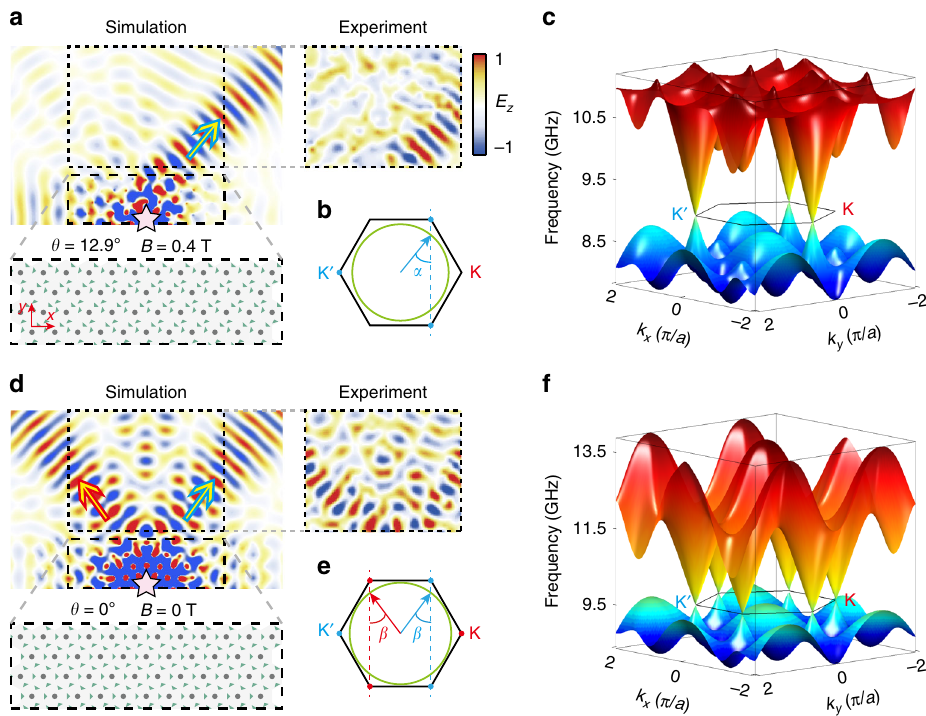
Fig. 3 Refraction of unpaired and paired Dirac valleys into an empty waveguide. a Experimental and numerical fi eld maps for PhC sample with θ = 12.9° and B = 0.4 Tesla (whose bandstructure has an unpaired Dirac point at Κ ′ ), with an upper zigzag boundary with an empty waveguide. The point source indicated by a pink star operates at 9.05 GHz. A single directional beam is emitted into the empty-waveguide region (blue arrow), caused by refraction from the Κ ′ valley inside the PhC. b k -space analysis of how PhC valley modes outcouple. The three blue dots indicate the Κ ′ point, and the green circle is the isofrequency surface of TM empty-waveguide modes at the Dirac frequency. The resulting outcoupling angle is α = 39.1°, consistent with the experimental results. c 2D bandstructure of PhC with θ = 12.9° and B = 0.4 Tesla. d Experimental and numerical fi eld maps for PhC sample with θ = 0° and B = 0 Tesla (whose bandstructure has Dirac points at K and K ′ ), with point source (pink star) operating at 9.76 GHz. Two directional beams are emitted into the empty-waveguide region (red and blue arrows), caused by refraction from K and Κ ′ valley states inside the PhC. Simulated fi eld distribution shows mirror symmetry, while the slight distortion of the measured result is due to unavoidable experimental errors. e k -space analysis for the PhC with paired Dirac points, which yields an outcoupling angle β = 35.8°, consistent with experimental results. f 2D bandstructure of PhC with θ = 0° and B = 0 Tesla.